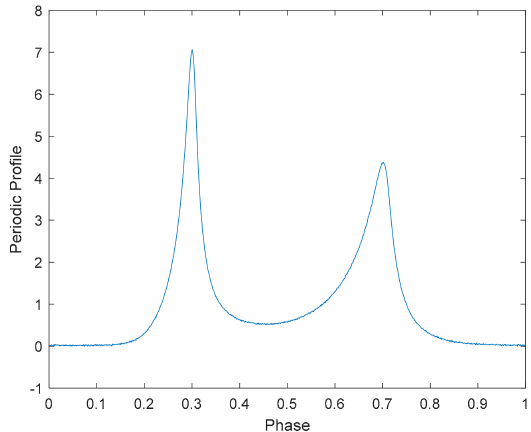
Figure 8. Profile of Crab pulsar.